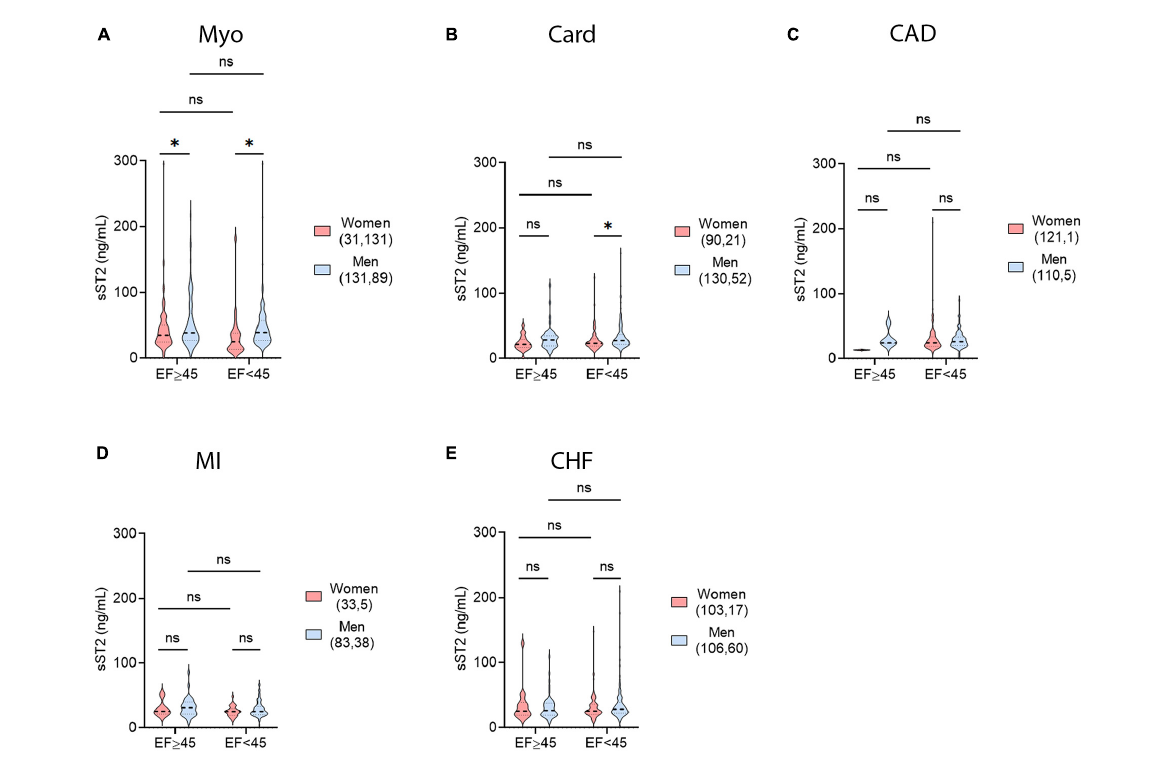
FIGURE6 Sex differences in LVEF and sST2. sST2 levels compared women (peach) vs. men (blue) with a left ventricular ejection fraction (LVEF) of ≥ 45% vs. < 45% for (A) myocarditis (Myo), (B) cardiomyopathy (Card), (C) coronary artery disease (CAD), (D) myocardial infarction (MI), or (E) congestive heart failure (CHF). Violin plots denote data distribution for each group. One-way ANOVA: (A) p = 0.024, (B) p = 0.023, (C) p = 0.79, (D) p = 0.17, and (E) p = 0.36 with two-way comparisons analyzed using unpaired Student’s t- test: ∗ , p < 0.05; ns, not significant. (A) Two-way ANOVA p- values indicate no interaction between EF and sex ( p = 0.59) in patients with myocarditis, but interactions between LVEF and sST2 ( p = 0.04) and sex and sST2 ( p = 0.0036). (B) Two-way ANOVA p -values indicate no interactions between EF and sex ( p = 0.81) or EF and sST2 ( p = 0.22) in patients with cardiomyopathy, but interactions between sex and sST2 ( p = 0.01). (C) Two-way ANOVA p -values indicate no interactions between EF and sex ( p = 0.34), EF and sST2 ( p = 0.48), or sex and sST2 ( p = 0.40) in patients with CAD. (D) Two-way ANOVA p- values indicate no interactions between EF and sex ( p = 0.77), EF and sST2 ( p = 0.23), or sex and sST2 ( p = 0.39) in patients with MI. (E) Two-way ANOVA p- values indicate no interactions between EF and sex ( p = 0.21), EF and sST2 ( p = 0.87), or sex and sST2 ( p = 0.85) in patients with